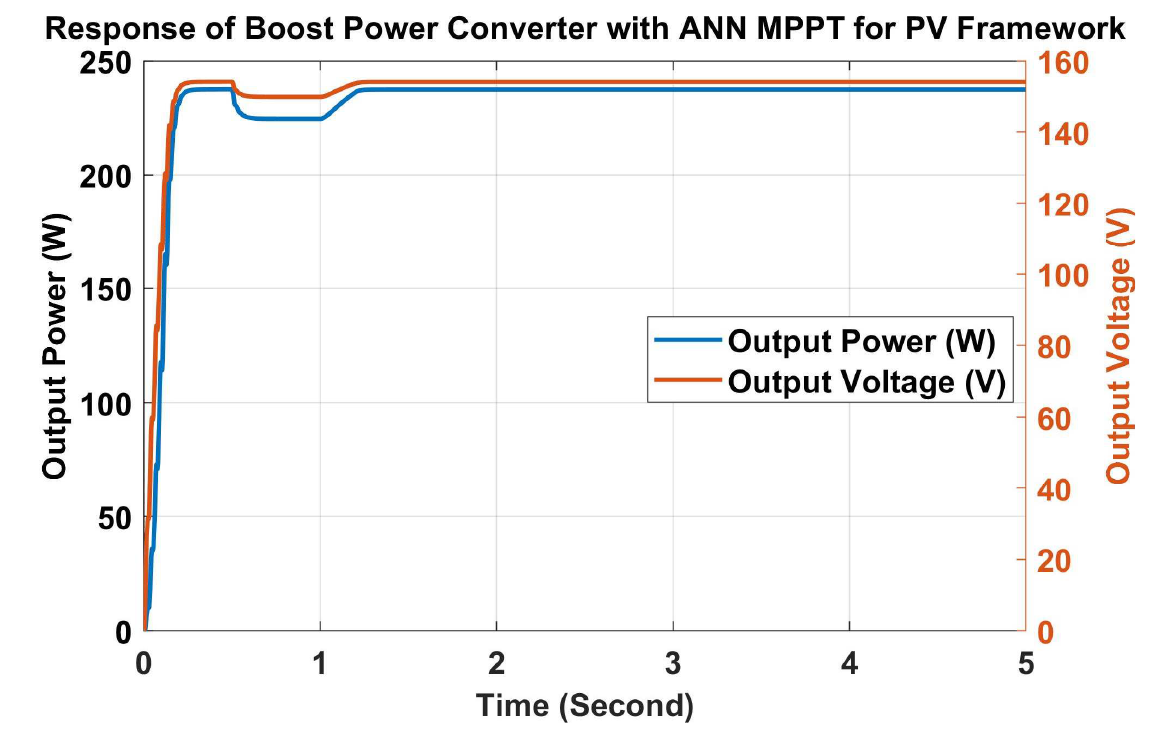
Figure 24. Output Power and Voltage of Boost Power Converter with AN-N MPPT for PV Frame-work.